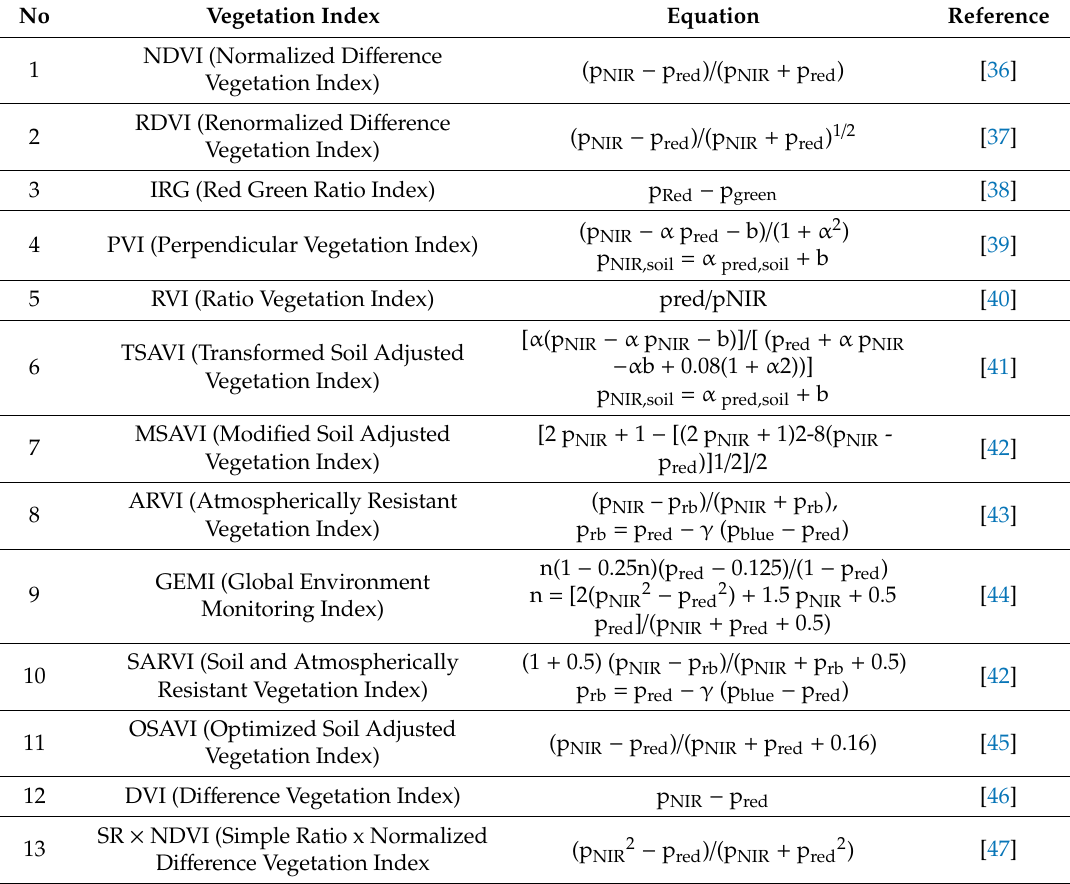
Table A1. Multispectral vegetation indices used in the study.